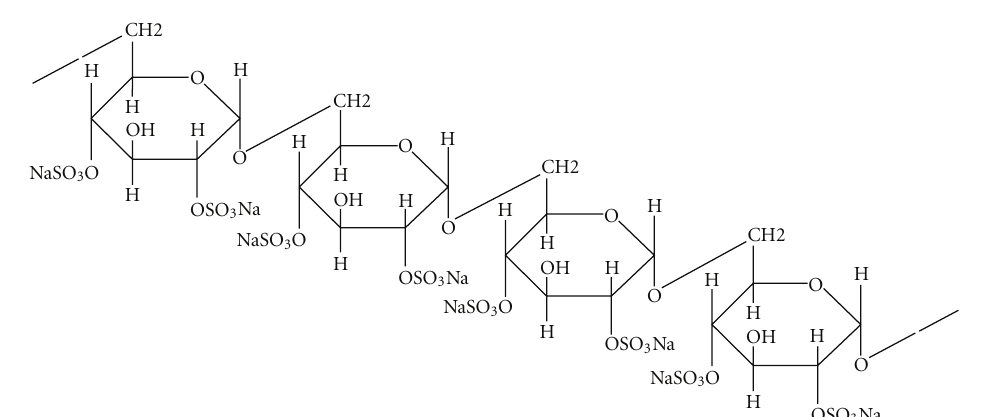
Figure 4: Chemical structure of dextran sulfate sodium (DSS), a sulfated polysaccharide, and its biological activities. DSS (1–5% in drinking water or diet) induces colitis in rodents. Treatment with DSS (1% in diet) after DMH exposure produces colonic adenocarcinoma [44]. The tumorigenicityof DSS is non-genotoxic e ff ects [20]. Cycle treatment with 3% DSS (MW 54,000, 7 days) and distilled water (14